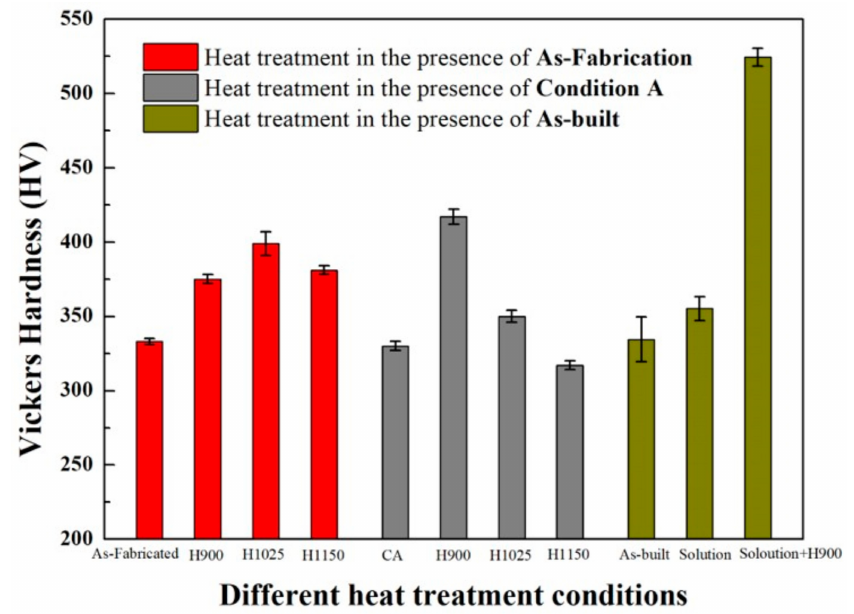
Figure 13. Hardness under di ff erent heat treatment conditions, material: 17–4 steel